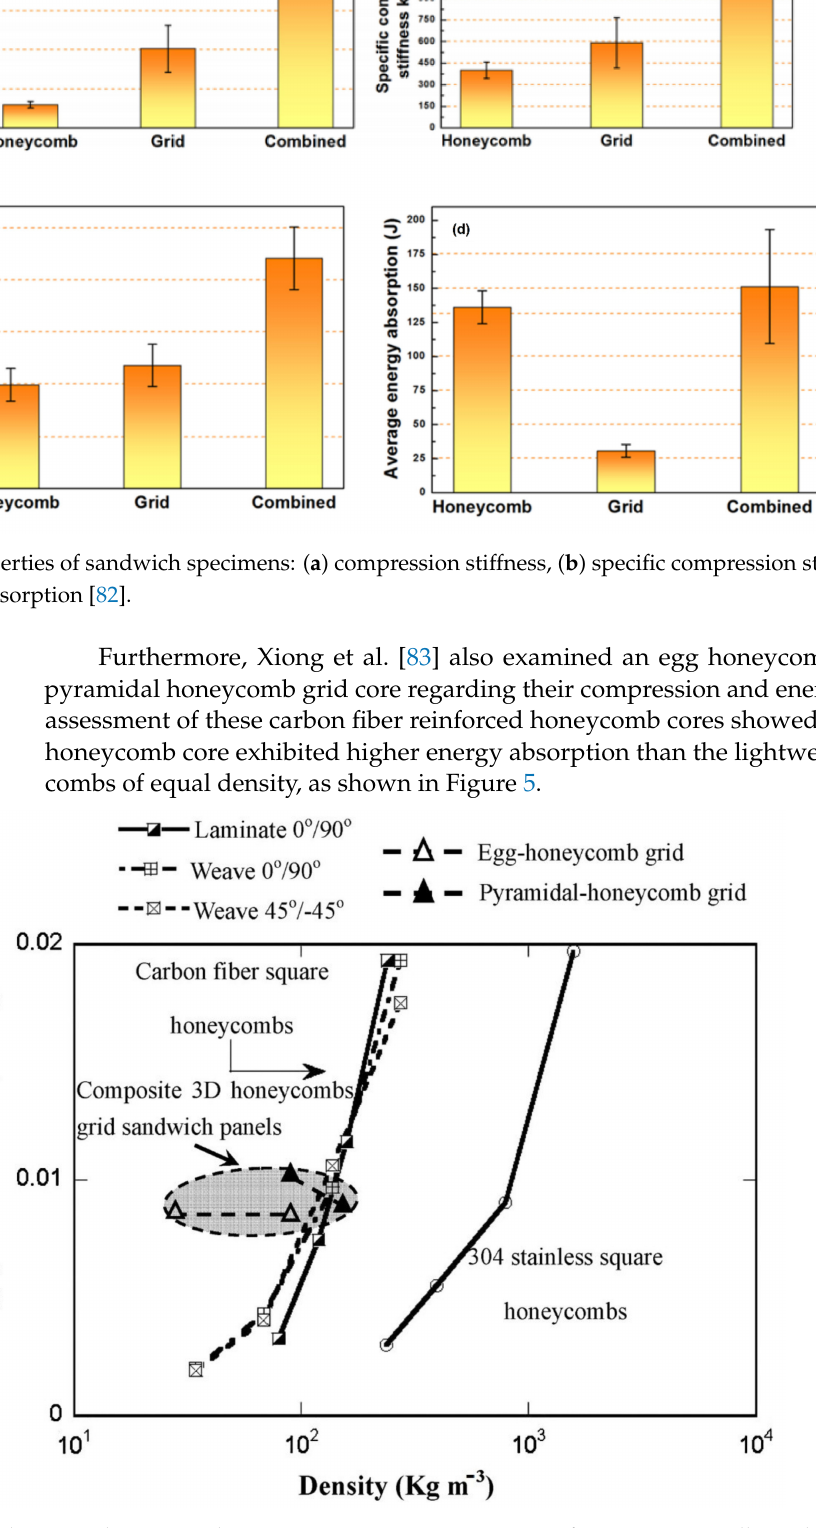
Figure 5. A comparison between the energy absorption capacities per unit mass of competing metallic and composite grids sandwich panels, as reported in